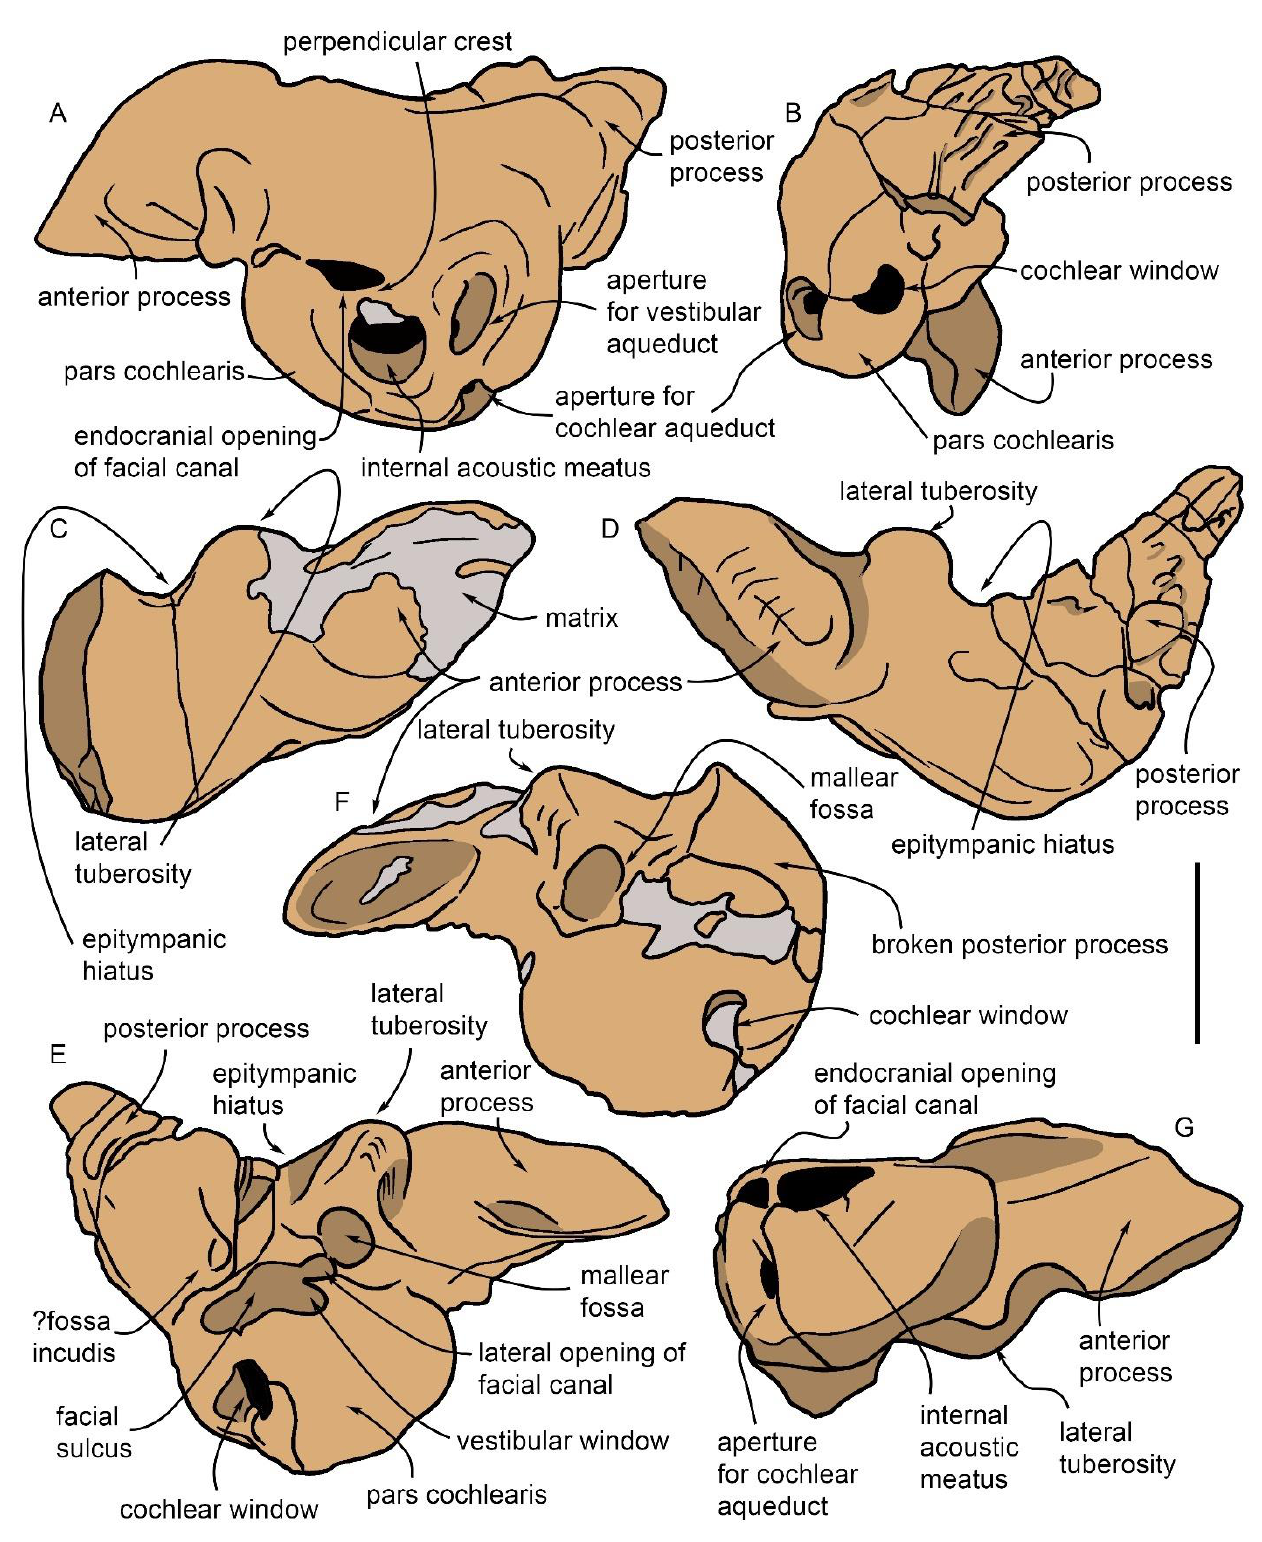
Figure 12. Anatomical interpretation of periotic morphology. ( A ) Medial view. ( B ) Posterior view. ( C ) Dorsal view of MGPT-PU 13906. ( D ) Dorsal view of MGPT-PU 13881/2. ( E ) Lateral view of MGPT-PU 13881/2. ( F ) Lateral view of MGPT-PU 13906. ( G ) Ventral view of MGPT-PU 13906. Scale bar equals 2 cm.